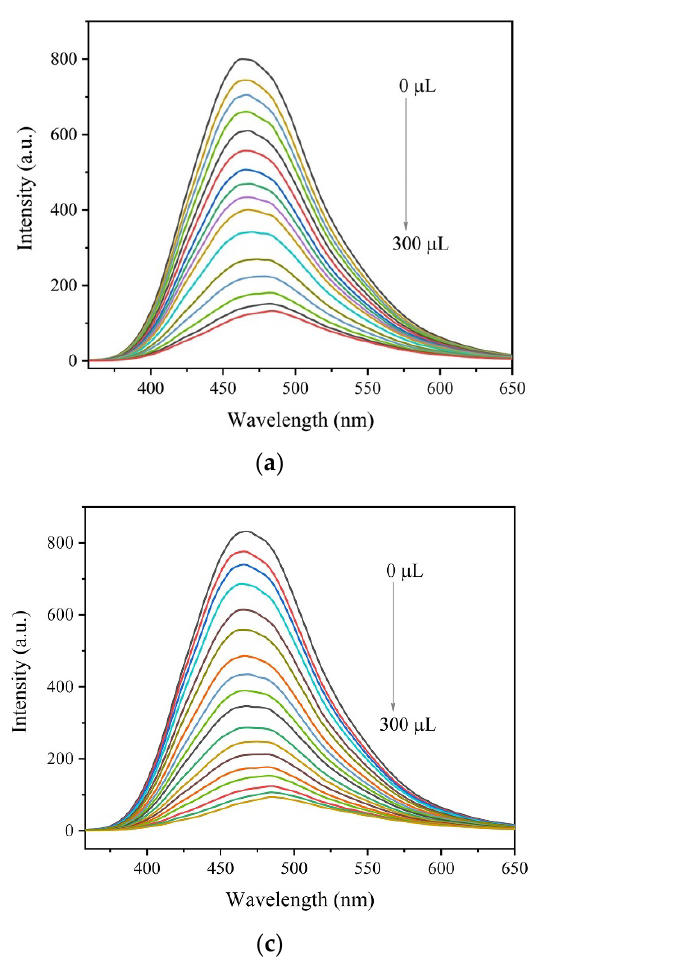
Figure 3. Fluorescence titration of 1 with gradual addition of Glu ( a ) and Asp ( c ). The S-V plot of I 0 /I − 1 vs. the concentration of Glu ( b ) and Asp ( d ). Inset: enlarged view of S-V plot in the low concentration range and the calculated quenching constant K sv .